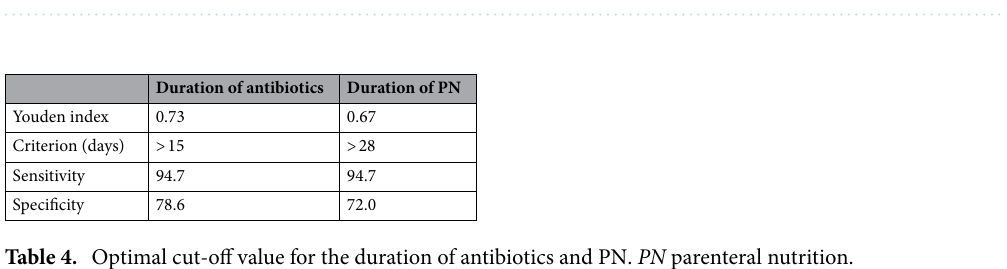
Figure 1. Receiver operating characteristic curve for the duration of antibiotics ( A ) and parenteral nutrition ( B ). AUC, area under the receiver operating characteristic curve.